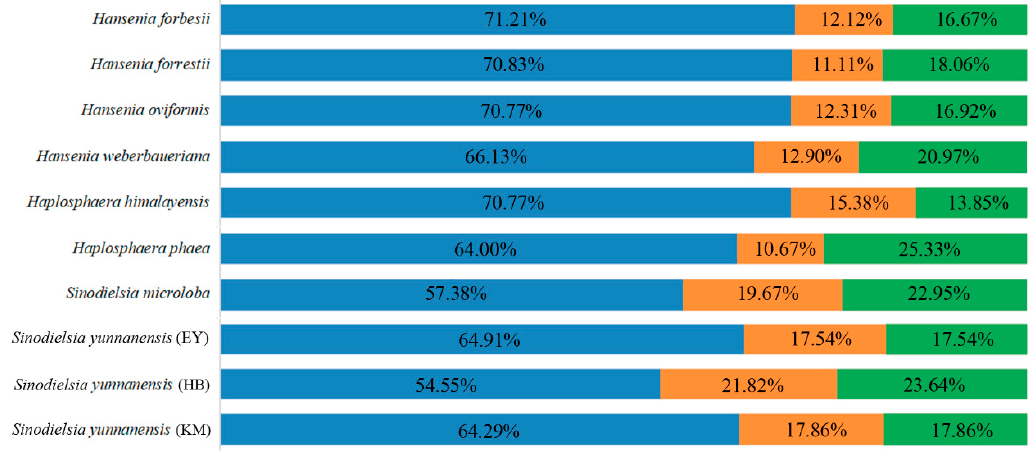
Figure 6. Frequency of detected SSR motifs in LSC (blue), IR (orange) and SSC (green) regions of the ten Hansenia , Haplosphaera and Sinodielsia plastid genomes.